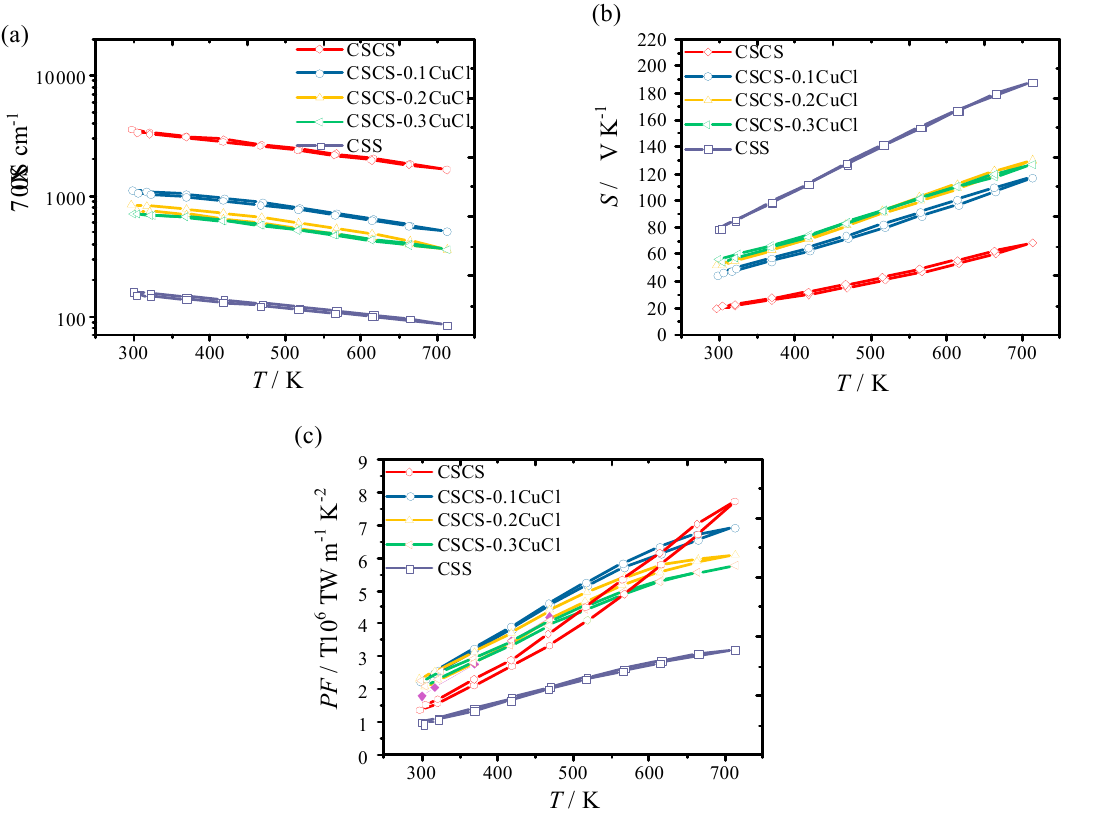
Figure 4. Thermoelectric properties (( a ) electrical conductivity, σ , ( b ) Seebeck coefficient, S , ( c ) power factor, PF ) as a function of temperature for CSCS- x CuCl ( x = 0, 0.1, 0.2, 0.3) samples.